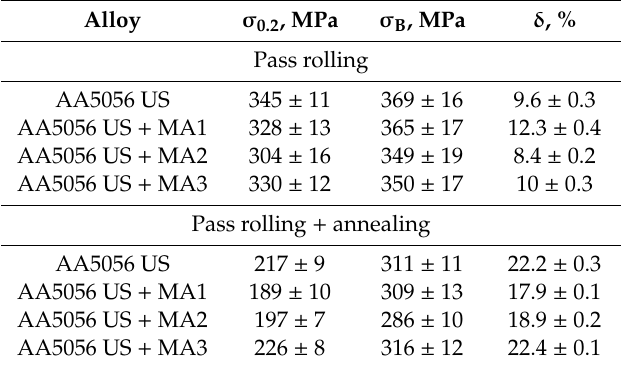
Table 4. The mechanical properties of deformed AA5056-based